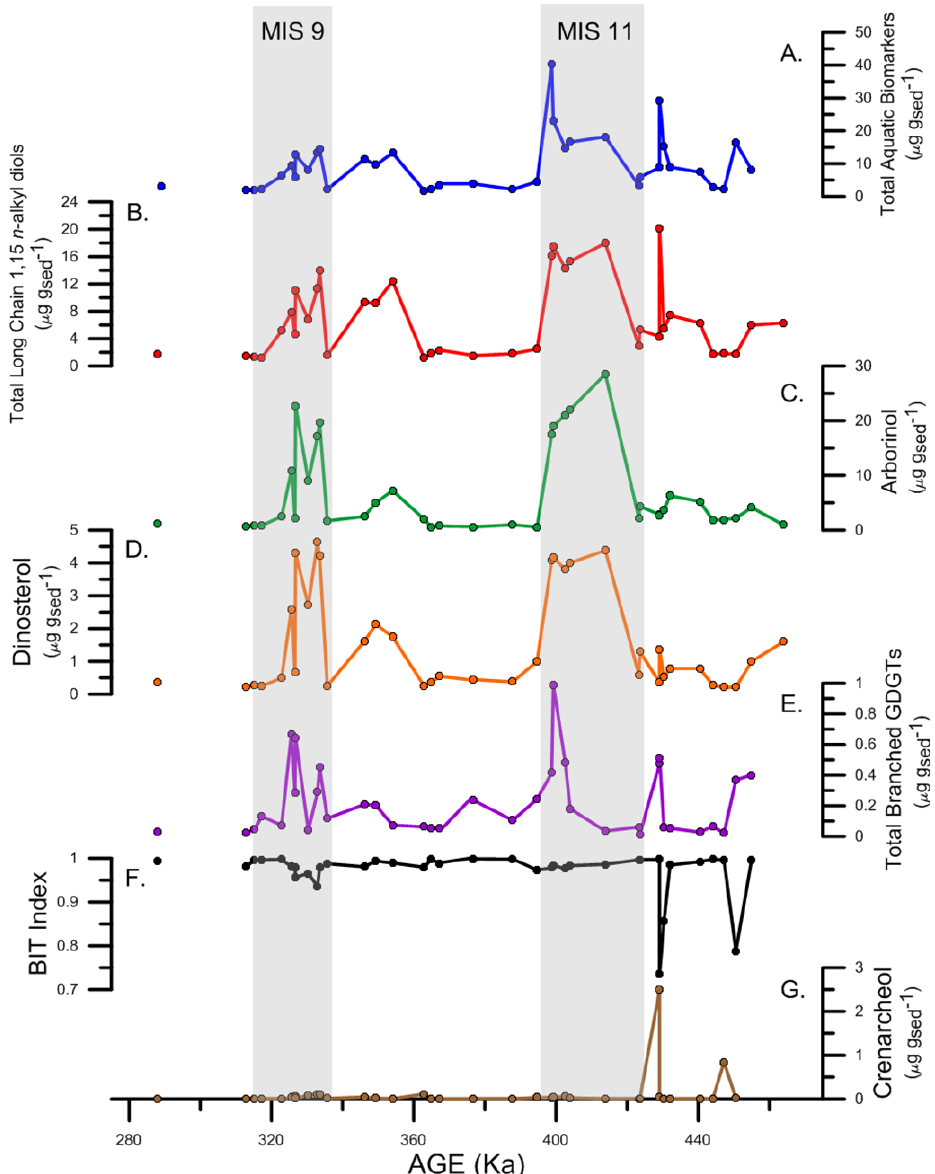
Fig. 2. ( a through g ) Calculated and measured organic geochemical proxies for the period of 275Ka to 475Ka for (a) total aquatic biomarkers, defined as the 6 [C 17 ]+[C 19 ]+[C 21 ]+[dinosterol] + [ 6 long chain (C 28 , C 30 , C 32 ) n -alkyl diols]; (b) sum of long chain (C 28 , C 30 , C 32 ) ) ; (d) dinosterol (µgg − 1 ) . (e) Concentrations of total branched GDGTs (µgg − 1 1,15 n -alkyl diols; (c) arborinol (µgg − 1 sed sed ) . Gray bars indicate the timing of MIS 9 and MIS 11 interglacial periods. (g) crenarchaeol (µgg − 1 sed